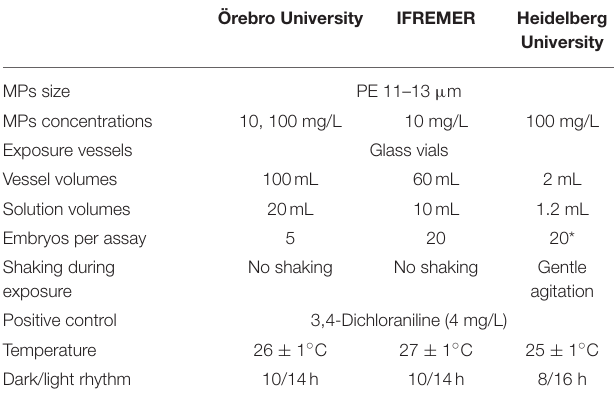
TABLE 2 | Overview about the test conditions and solutions for the zebrafish embryo toxicity test used by the three different